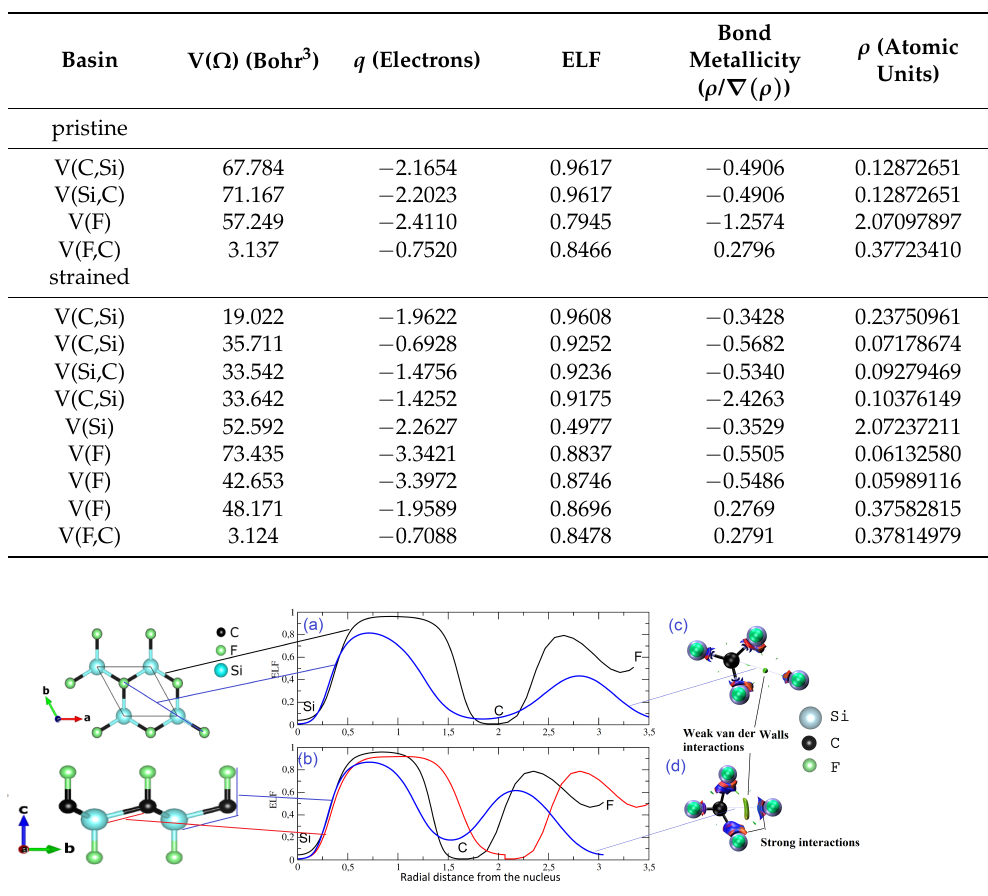
Table 4. Electron localization analysis of a basin of bonding of the CF 2 Si monolayer. V( Ω ), q , bond metallicity ( ρ / ∇ ( ρ ) ), and ρ stand, respectively, for basin volumes of disynaptic V(X,Y) and monosynaptic V(X) bonds, electronic charges of the bond, calculated bond metallicity and electronic density charge ( ρ ), and ELF (3, − 3) basin.